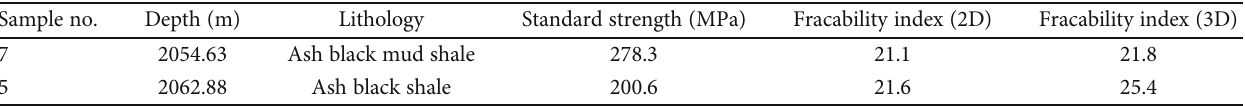
Table 5: Information of the three rock samples from the well X and the results of fracability analysis. Sample